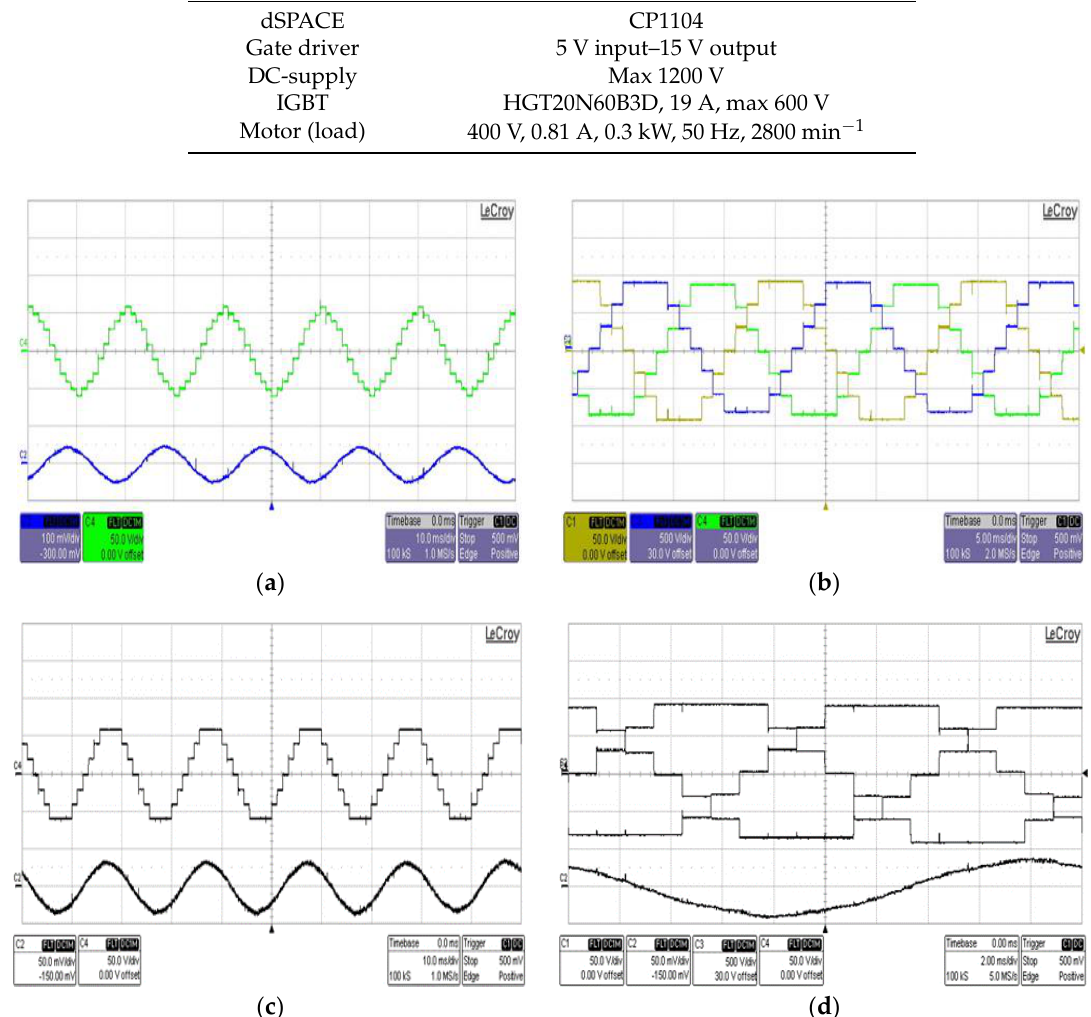
Figure 9. Experimental results for T-NPP. ( a ) Line to neutral voltage and current of the induction motor load. ( b ) Line-to-line voltages of the induction motor load. ( c ) Line-to-line voltage of leg a and load’s current. ( d ) Line-to-line voltages and induction motor load’s current.